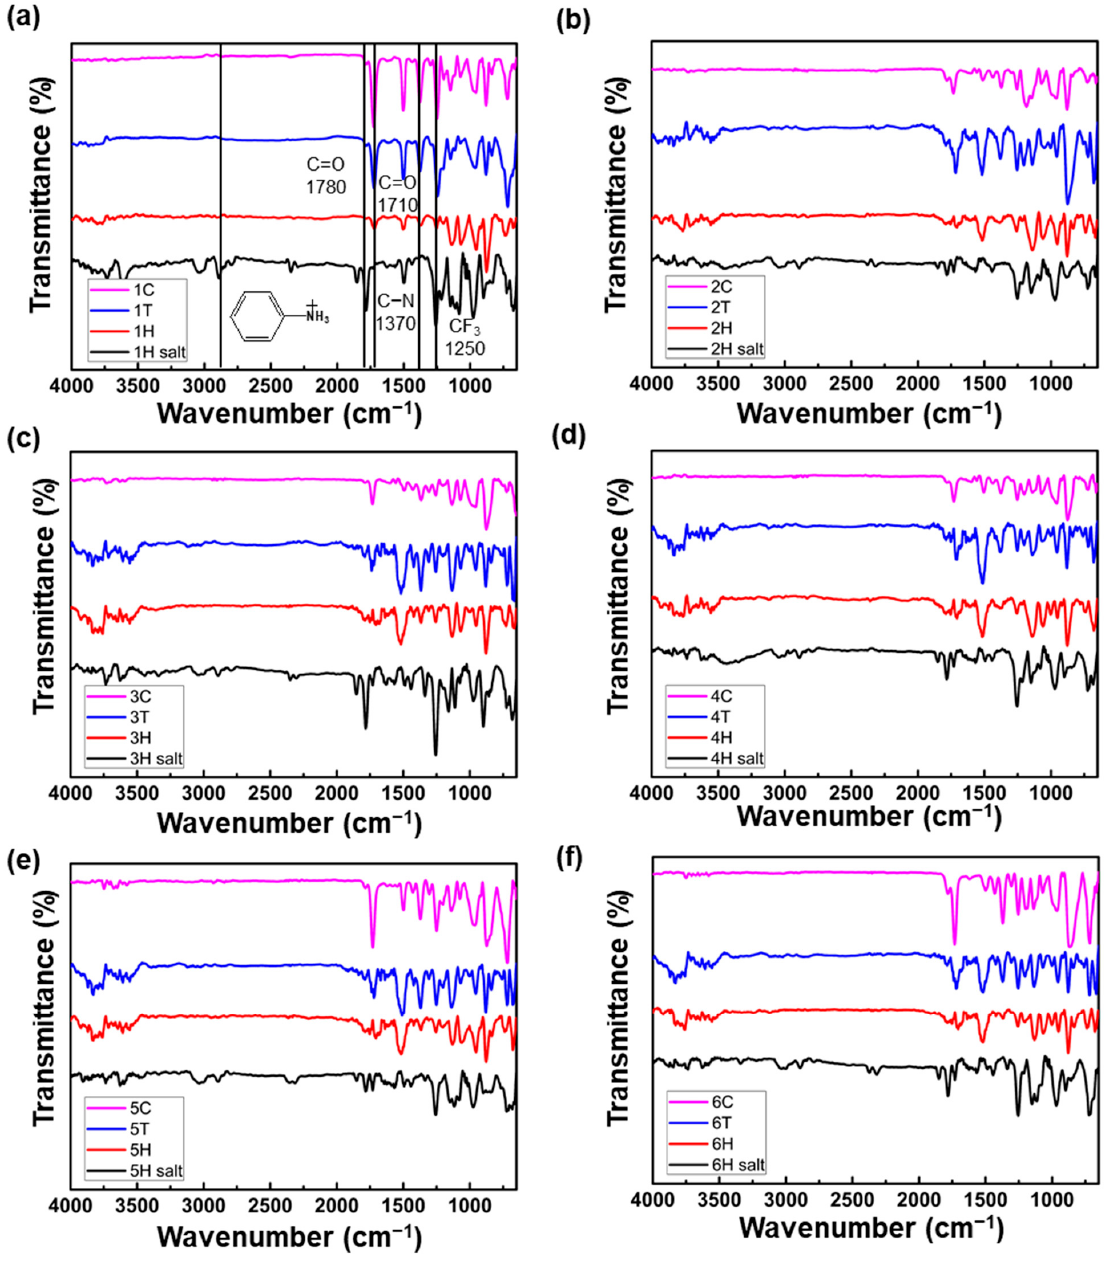
Figure 2. FT-IR spectra of monomer salts and polyimides synthesized with three different synthetic methods, ( a ) polyimide 1, ( b ) polyimide 2, ( c ) polyimide 3, ( d ) polyimide 4, ( e ) polyimide 5, ( f ) polyimide 6.